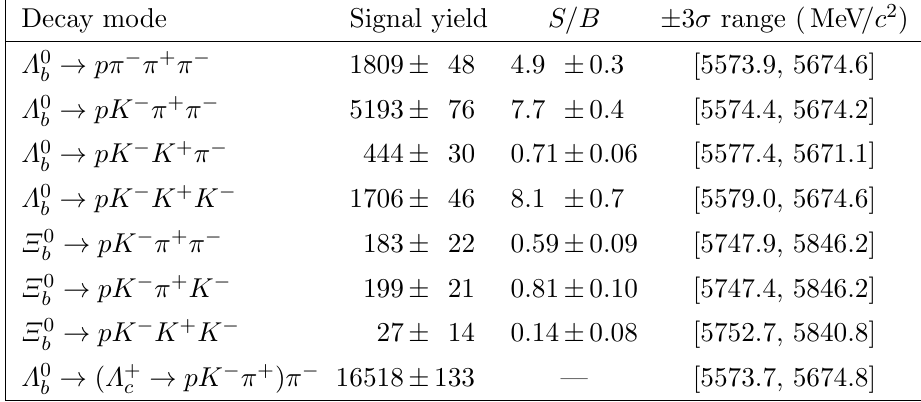
Table 1 . Signal yields for each decay mode, determined by summing the (cid:12)tted yields in each year of data taking. The signal ( S ) to background ( B , adding all sources) ratios in an invariant mass window, covering (cid:6) 3 times the measured signal widths, are provided. The corresponding invariant mass ranges are reported in the fourth